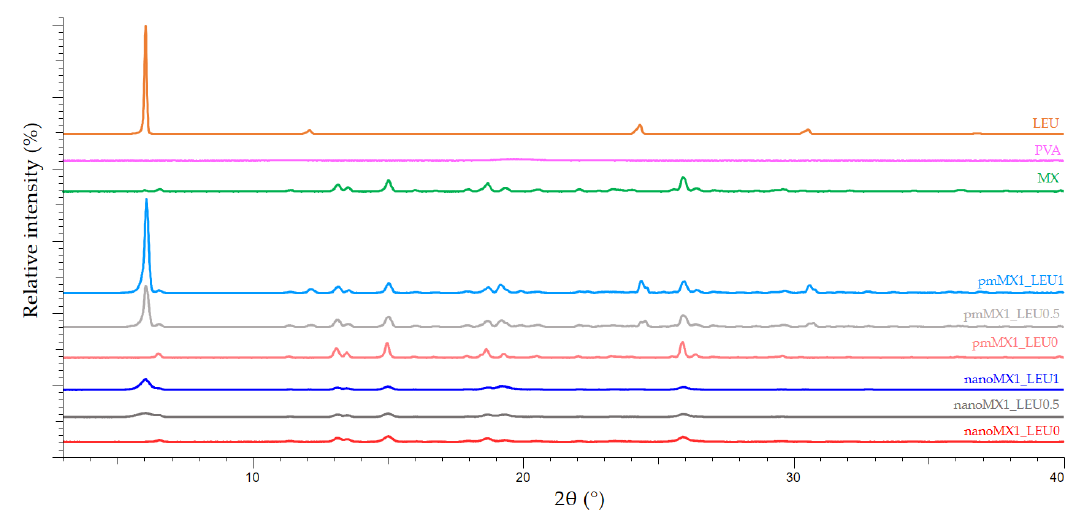
Figure 2. X-ray powder diffraction (XRPD) results of the raw materials ( L -leucine (LEU), poly-vinyl-alcohol (PVA), and meloxicam (MX)), the physical mixtures (pmMX1_LEU0, pmMX1_LEU0.5, and pmMX1_LEU1), and the spray-dried samples (nanoMX1_LEU0, nanoMX1_LEU0.5, and nanoMX1_LEU1).